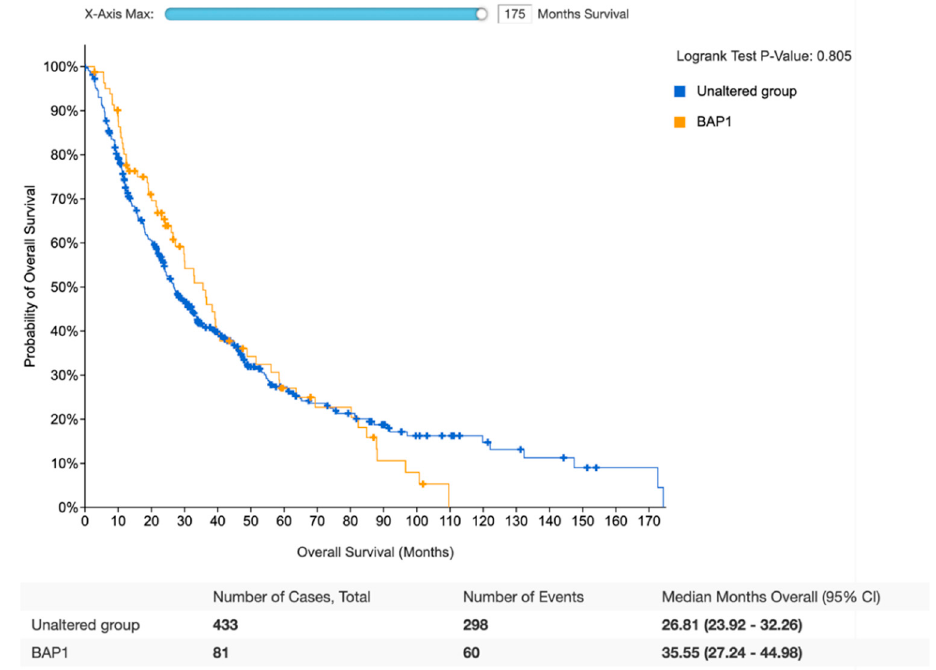
Figure 3. Kaplan–Meier analysis of overall survival of BAP1 -mutant iCCA patients versus BAP1 wild-type.